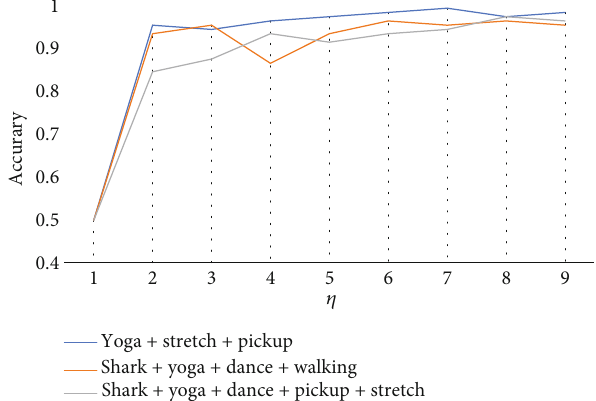
Figure 4: The x-axis represents the value of η , the y-axis represents the corresponding segmentation accuracy, and the three-colour line graph represents the three